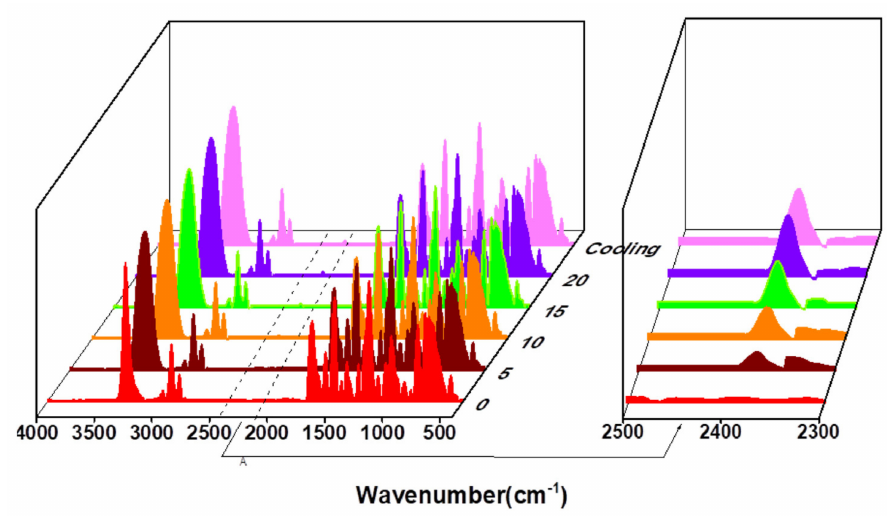
Figure 11. The IR spectra of P(Syol-MDI) vs. different heating